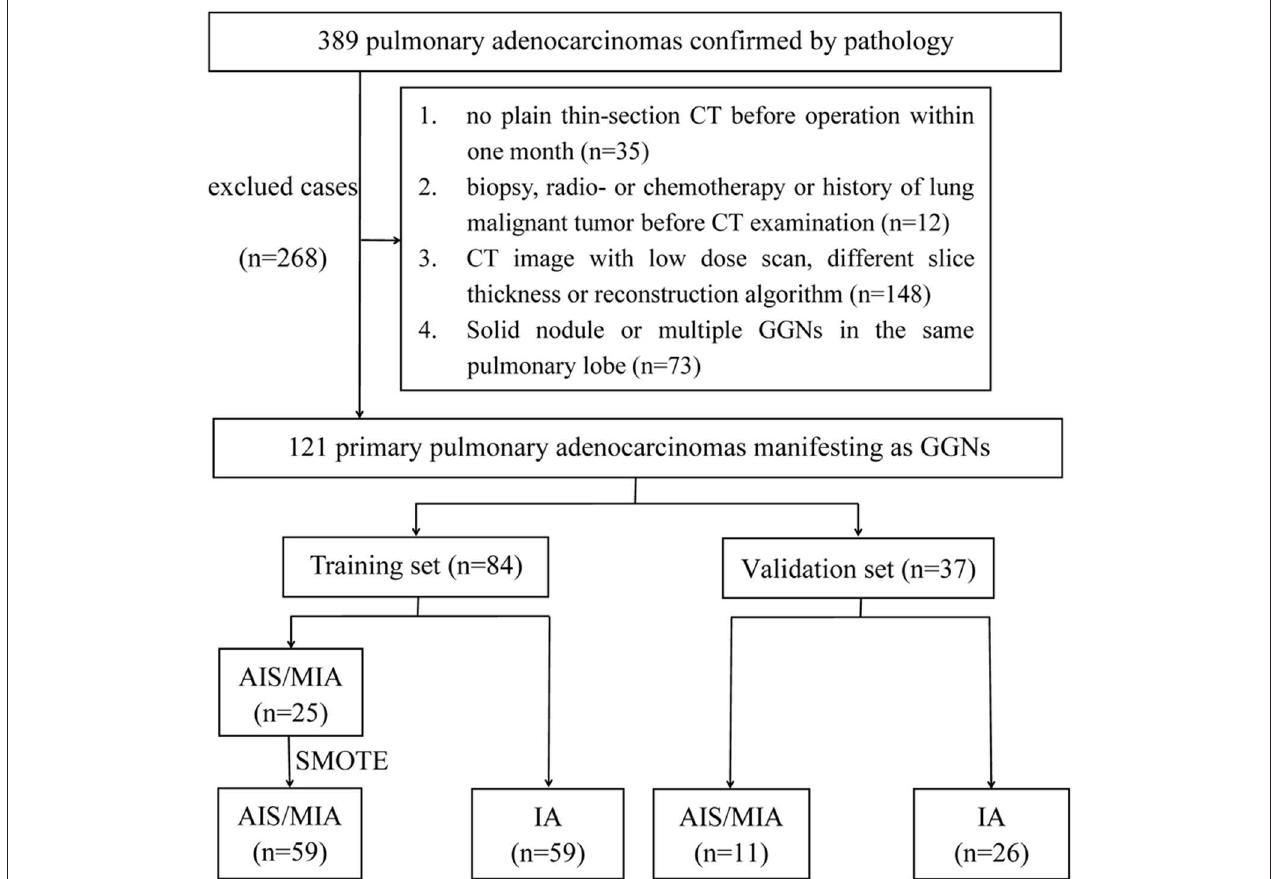
FIGURE 2 | Flowchart of study